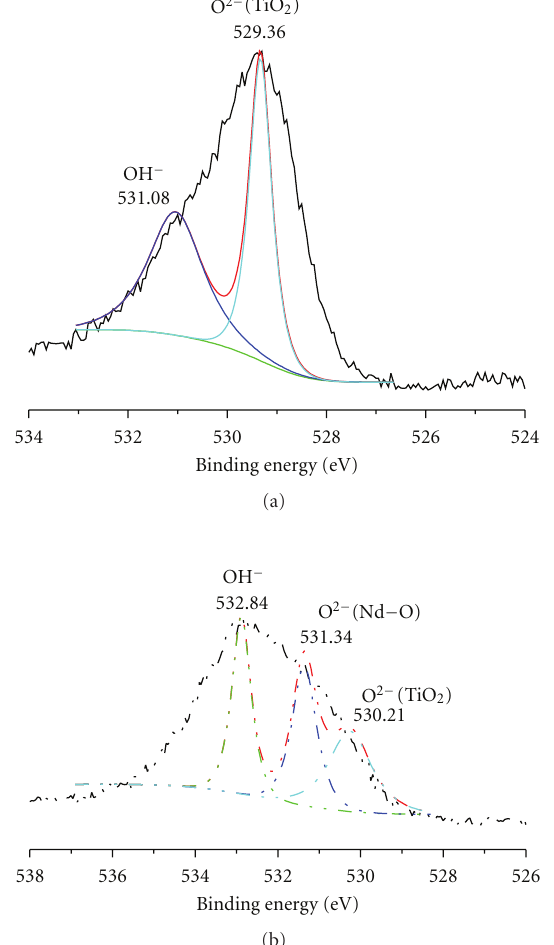
Figure 6: High-resolution XPS spectra of O 1s for pure TiO 2 (a) Nd-doped TiO 2 with Ti:Nd = 11 :1